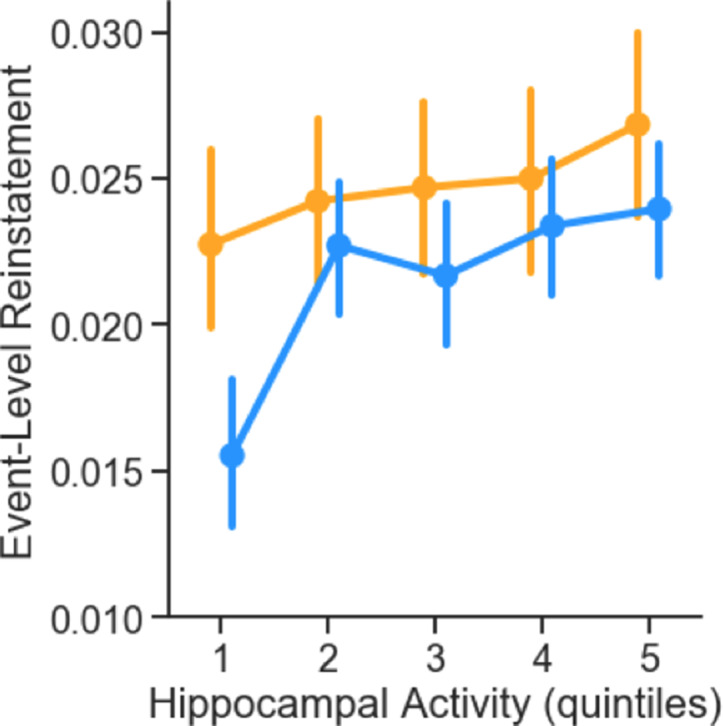
Trial-wise hippocampal activity is related to within-event ERS in VTC.For visualization, data for each participant are binned into quintiles based on hippocampal activity. Statistics were conducted on trial-wise data, z-scored within participant. Error bars represent standard error of the mean.VTC = ventral temporal cortex; ANG = angular gyrus. ERS = Encoding Retrieval Similarity.